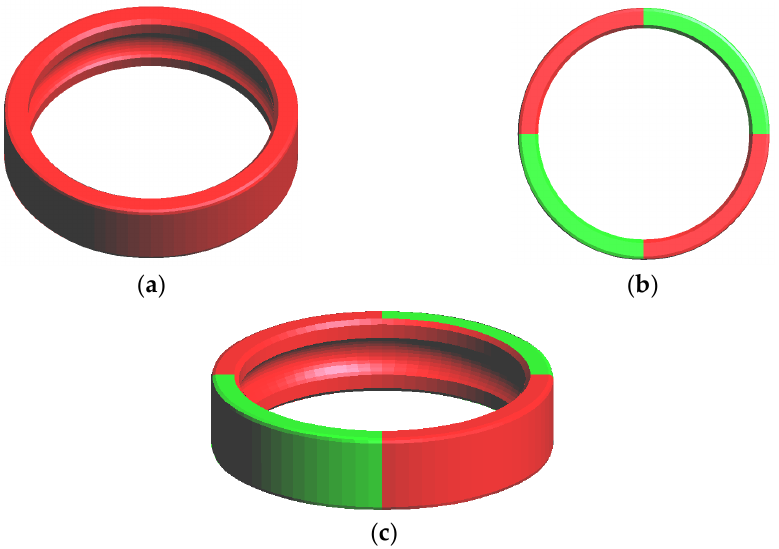
Figure 8. Heat transfer boundaries: ( a ) axial symmetry heat transfer ; ( b ) orthogonal symmetrical heat transfer ; ( c ) external orthogonal symmetrical and internal axial symmetry heat transfer.